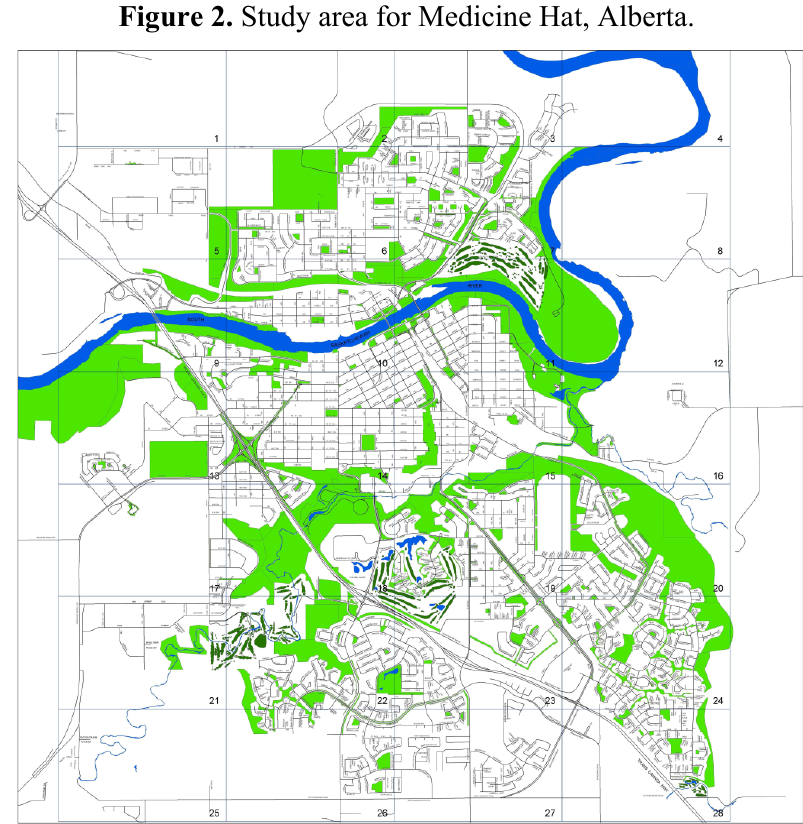
Figure 2. Study area for Medicine Hat,